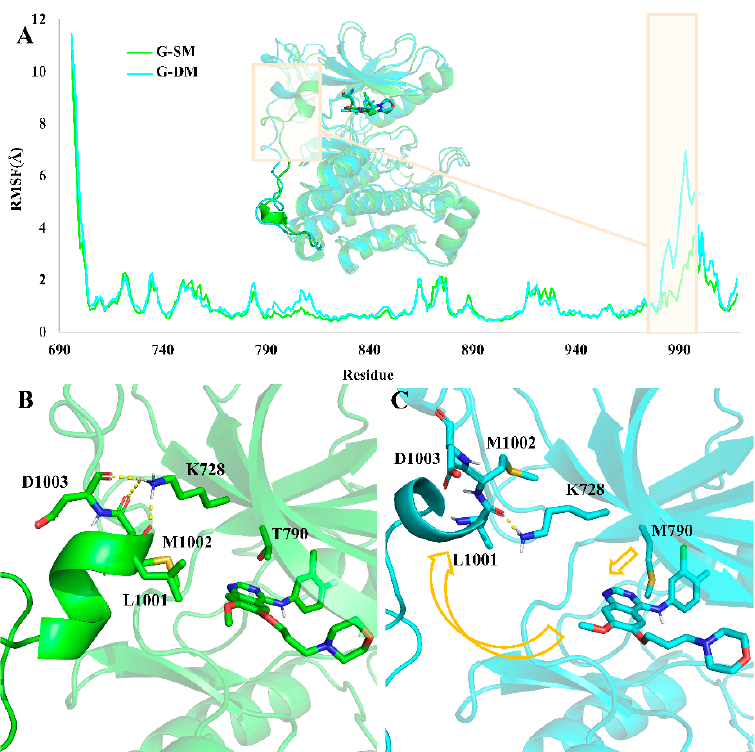
Figure 5. ( A ) RMSF value and aligned structure of G-SM (green) and G-DM (cyan) system. The major difference between SM and DM is labeled by a red rectangle. ( B ) The clustered structure of G-SM ( B ) and G-DM ( C ).